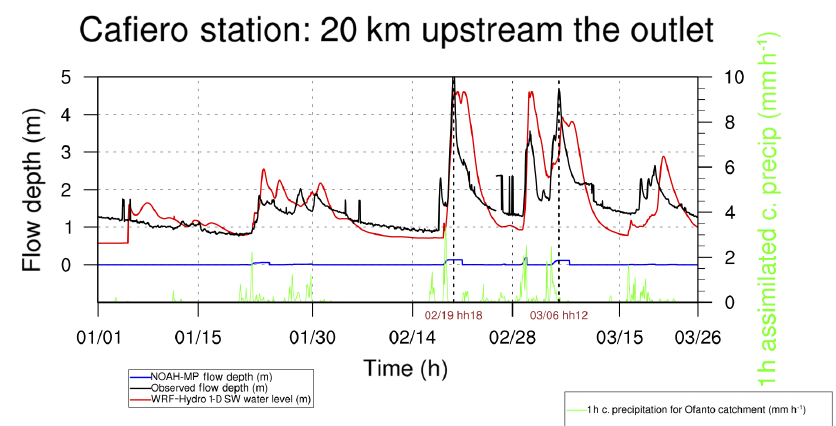
Figure 12. Comparison of the Ofanto discharge for Experiment 1 at Cafiero station as provided by the best WRF-Hydro set-up and by